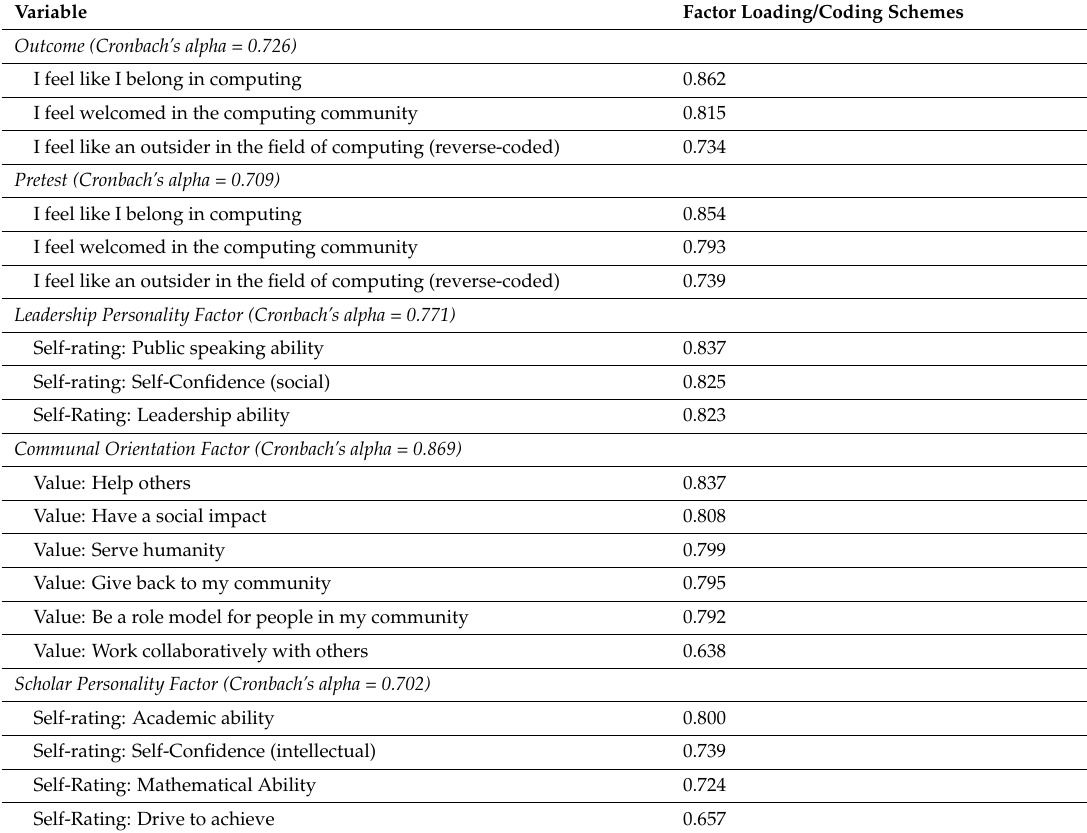
Table A2. Factor Loadings and/or Coding for all Composite Variables. Factor Loading/Coding